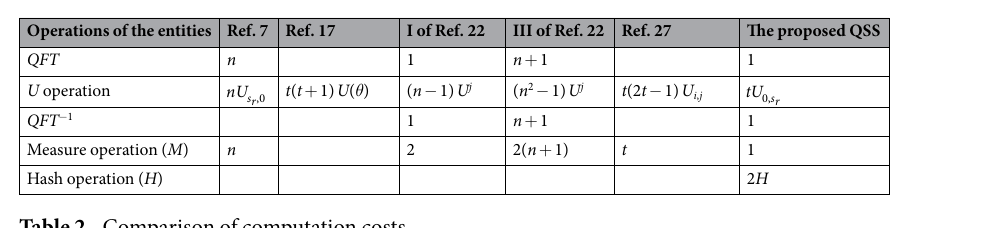
Table 2. Comparison of computation